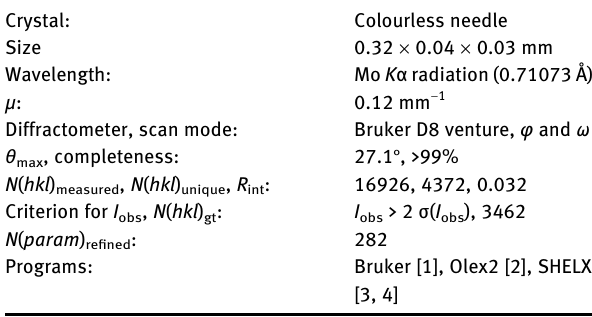
Table  : Data collection and